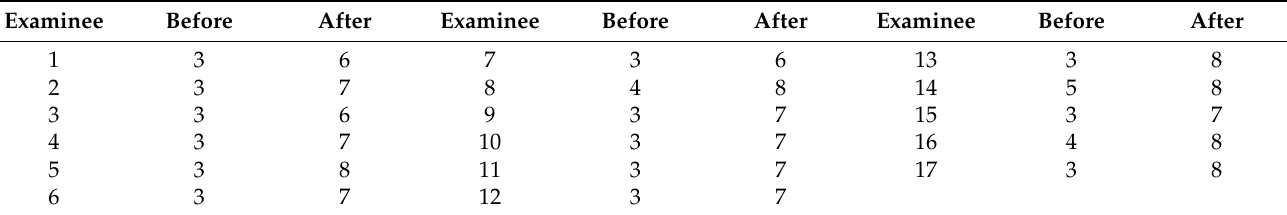
Table 2. KSS scores before and after brain fatigue.